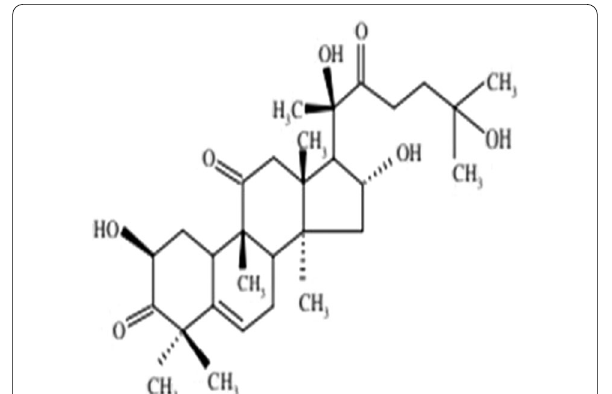
Fig. 4 23,24-dihydrocucurbitacin D